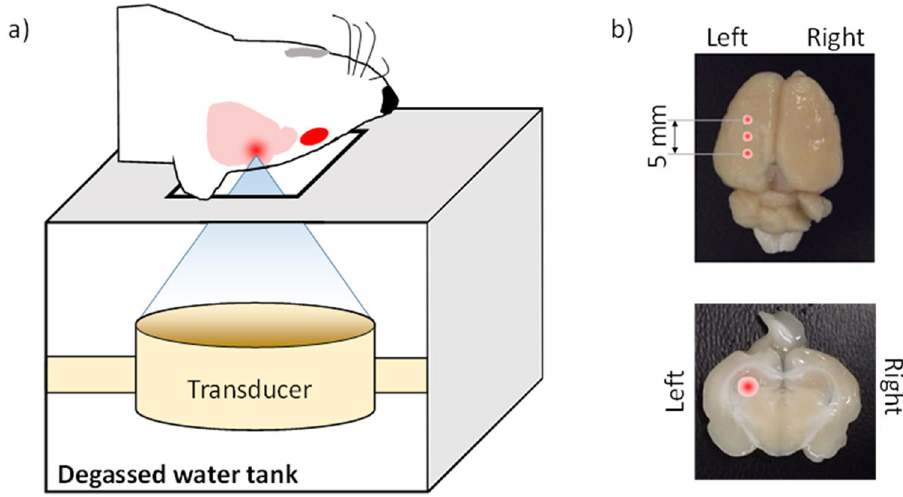
Figure 6. The FUS system was placed on the bed of a Revolution CT scanner while ( a ) rat’s head was placed over the transducer. ( b ) Locations of sonication points displayed on an excised rat’s